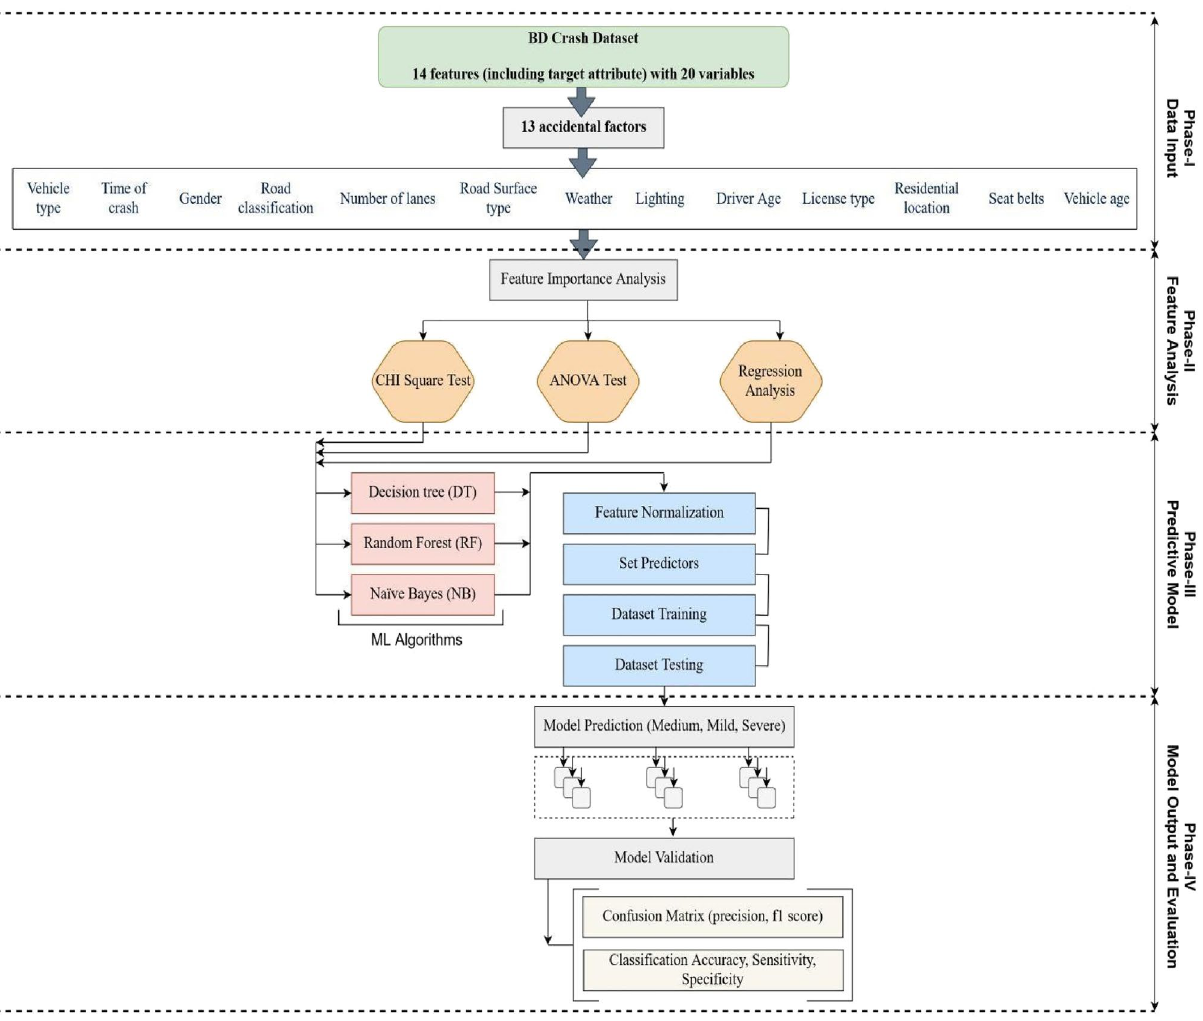
Figure 3. Analytical framework of crash severity